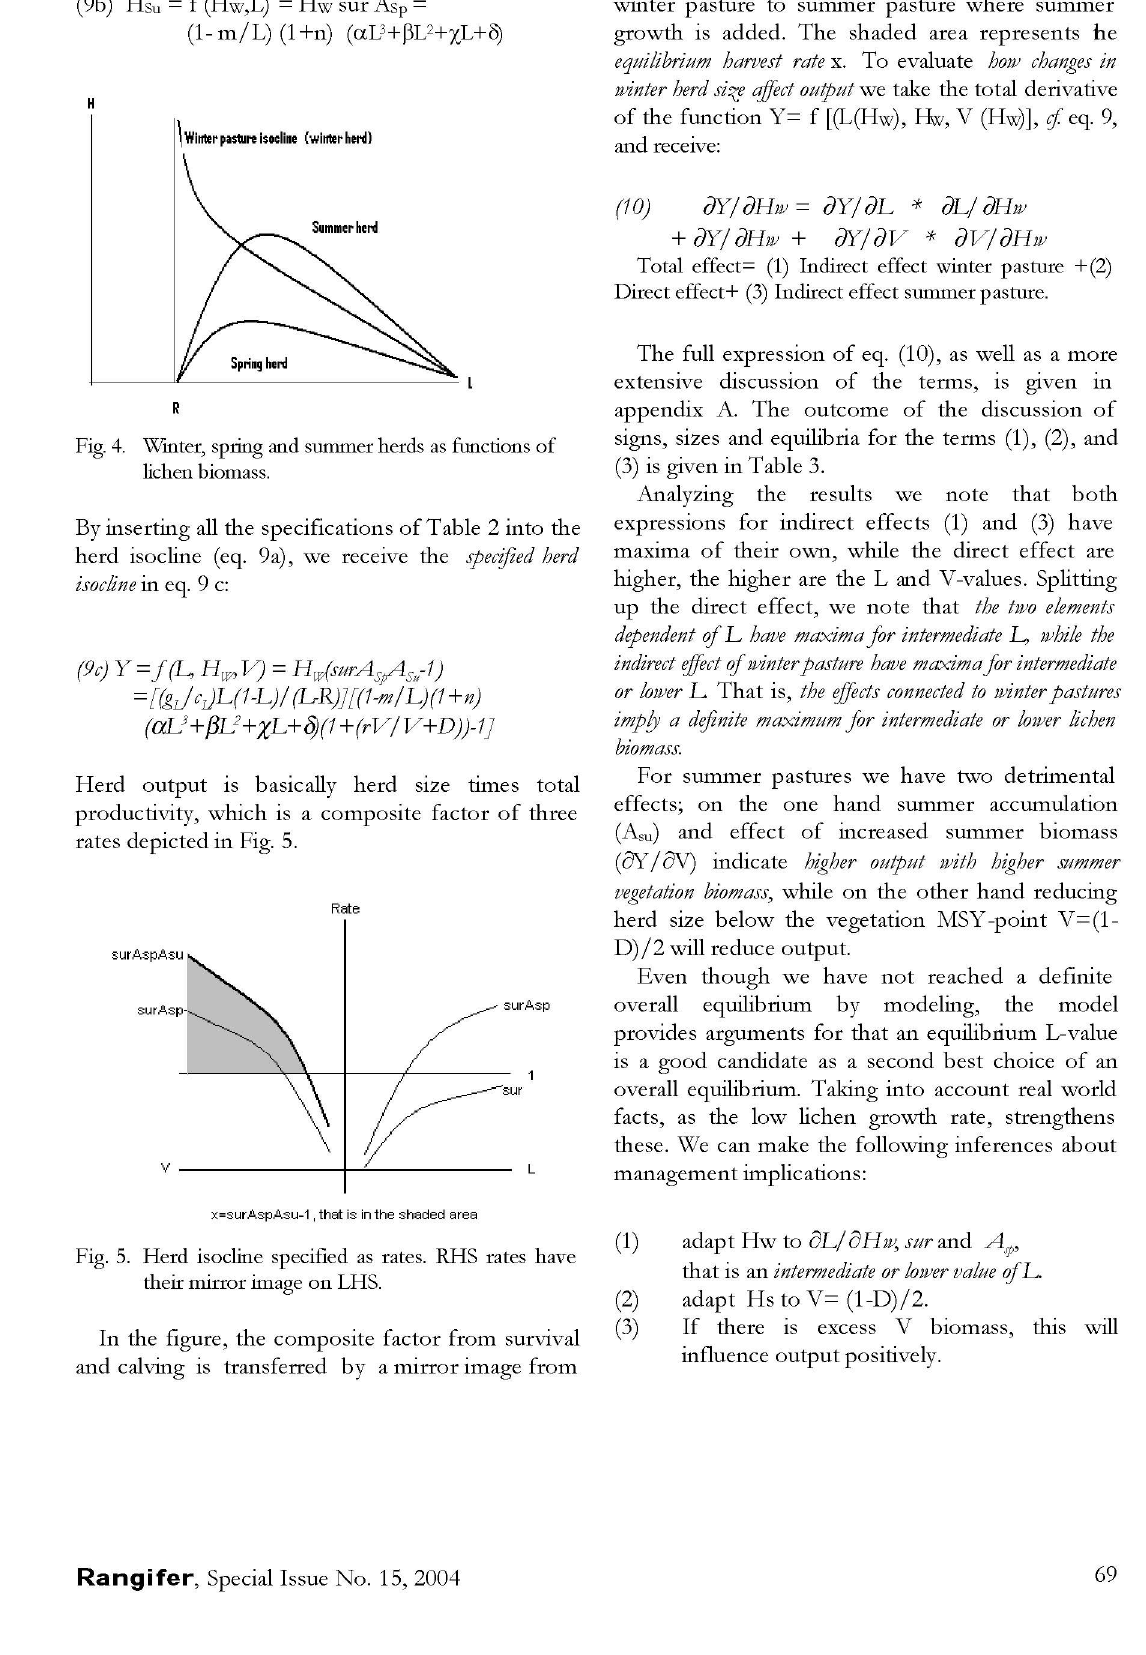
Fig. 5. Herd isocline specified as rates. RHS rates have their mirror image on